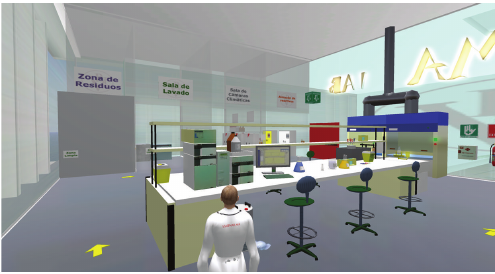
Figure 4: Snapshot of a tester during the pilots.